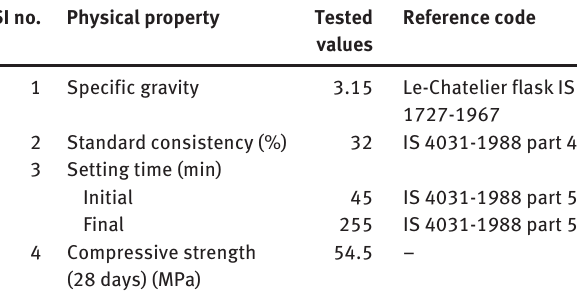
Table 1 Physical properties of